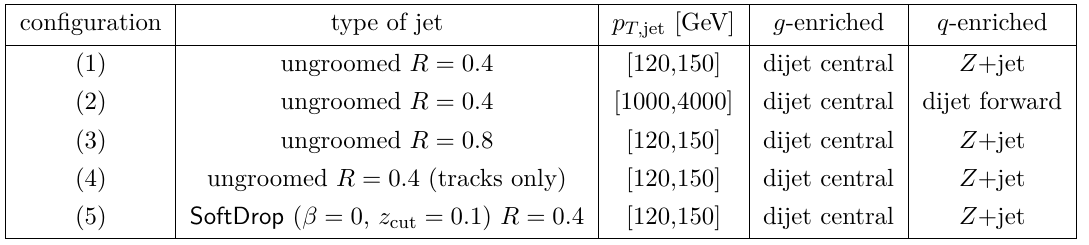
Table 2. Configurations selected in ref. [30] to test theory predictions for gluon-enriched and quark-enriched samples.